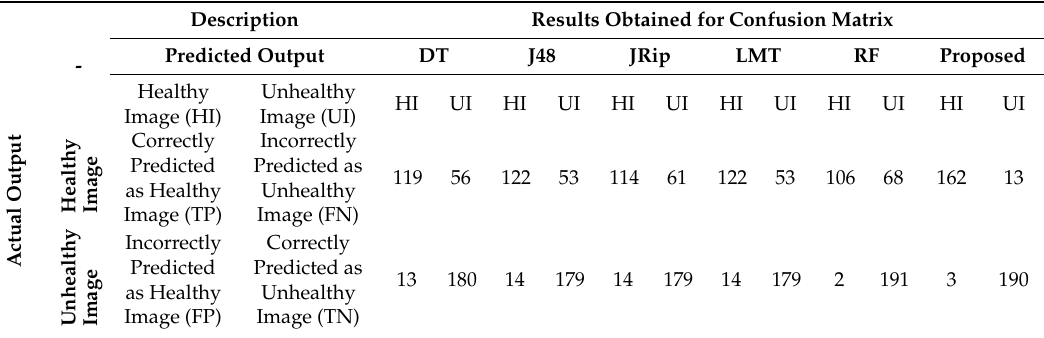
Table 4. Confusion Matrix.